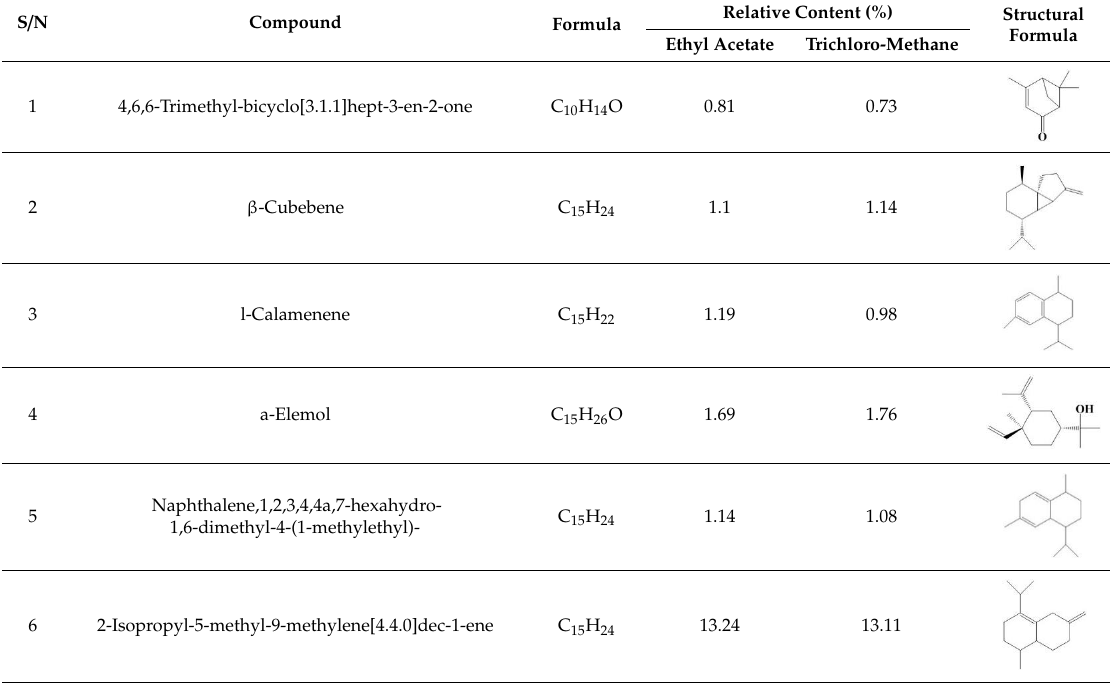
Table 1. Chemical compositions of Phoebe zhennan wood residue extracts S/N Compound